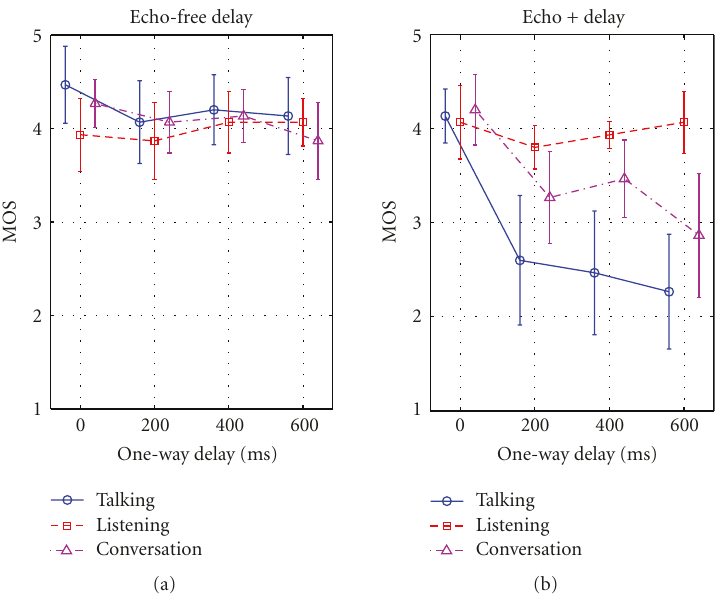
Figure 5: Echo and delay test